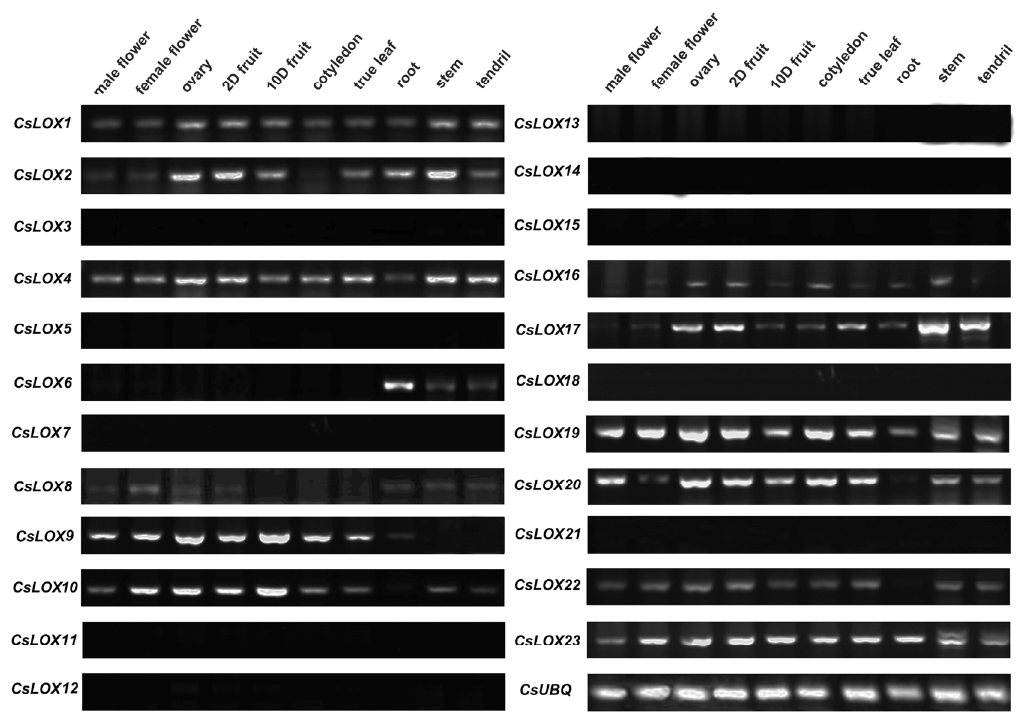
Figure 1. Semi-quantitative RT-PCR analysis of LOX genes in different tissues of cucumber ( Cucumis sativus ) cv Line 9930 (a cultivar of northern China) during development. Expressions of 23 cucumber LOX genes in male flower, female flower, ovary, 2 days old fruit, 10 days old fruit, cotyledon, true leaf, root, stem and tendril were analyzed. An amplified cucumber ubiquitin gene CsUBQ (Csa000874) was used as an internal control. The number of cycles of PCR for LOX genes was 30, while that for CsUBQ was